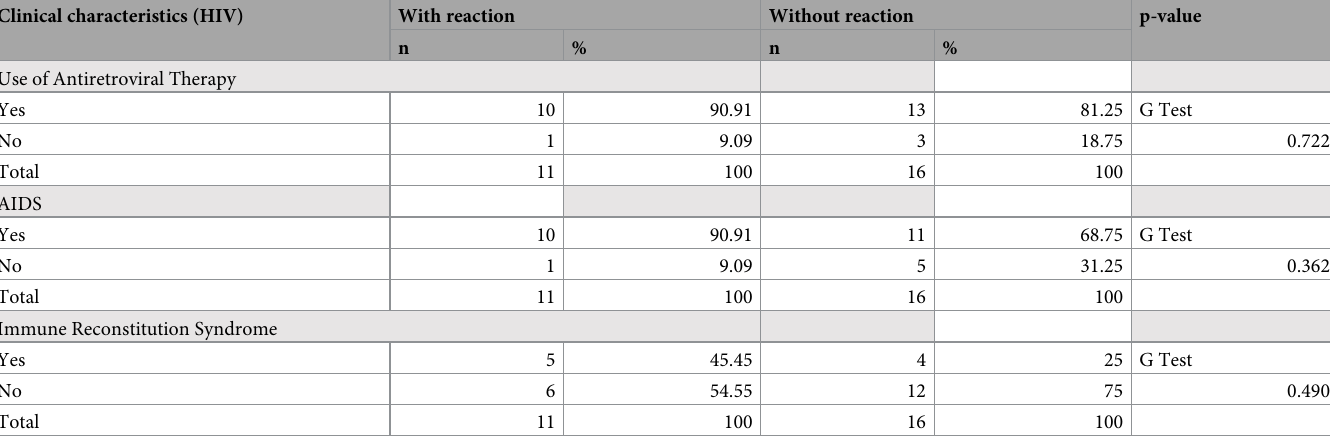
Table 3. Clinical characteristics related to HIV in patients with and without leprosy reaction treated at a referral center, Bele´m—Para´, from 2003 to 2017. Clinical characteristics